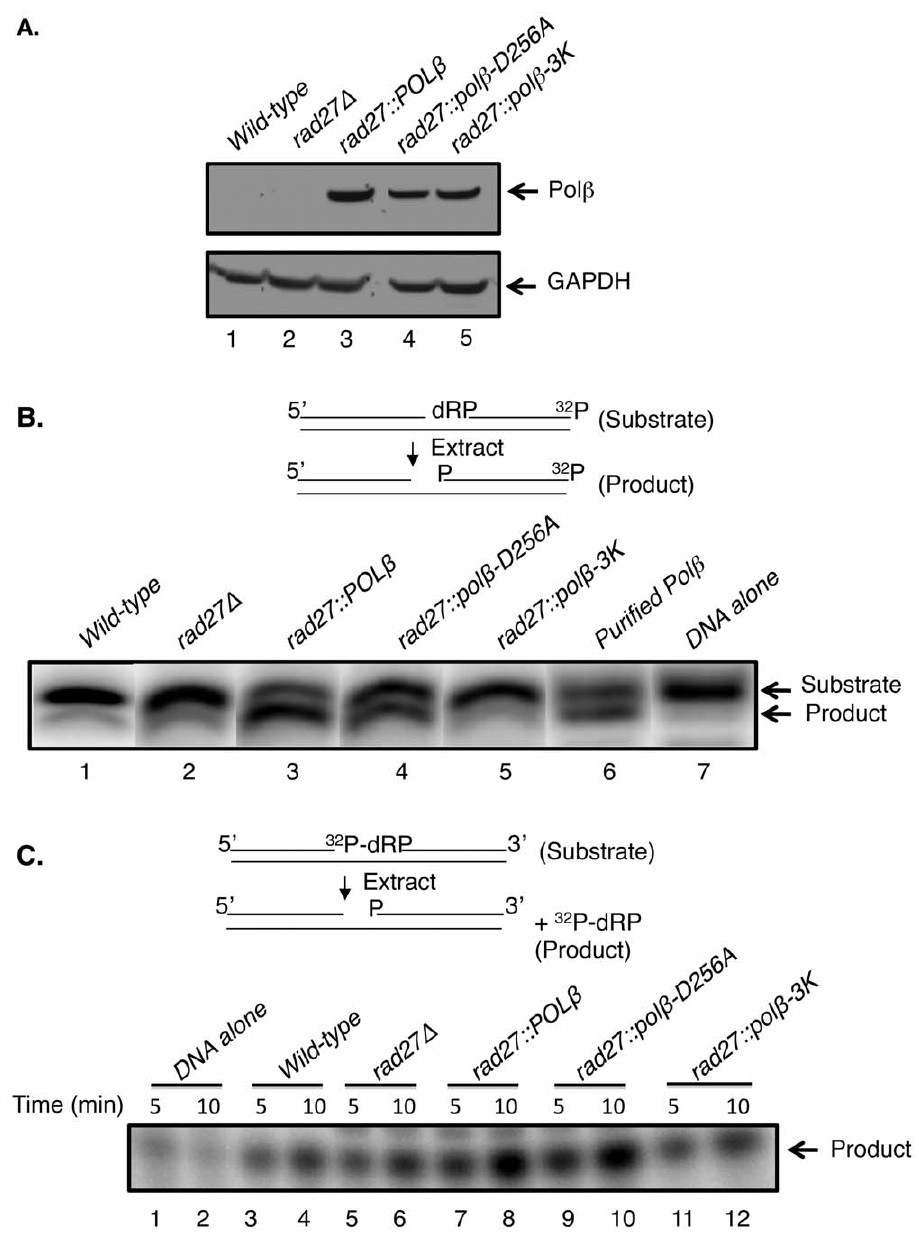
Figure 2. Expression of human POL b into S.cerevisiaerad27 mutants. (A) Immunoblot illustrating human Pol b expression in S. cerevisiae . Total extract protein was isolated (see Materials and Methods) from the indicated five strains. The indicated extracts (50 m l each) from wild-type (lane 1), rad27 D (lane 2), rad27::POL b (lane 3), rad27::pol b -D256A (lane 4), or rad27::pol b -3K (lane 5), respectively, were separated by SDS-PAGE, transferred to a nitrocellulose membrane, and probed either with an antibody against pol b (upper panel) or with an antibody against GAPDH (bottom panel). Bands corresponding to Pol b (39 kDa) were observed. GAPDH was used as a loading control. (B and C) 5 9 -dRP lyase assays. Schematic representations of the dRP lyase substrates (3 9 - or 5 9 -end 32 P-labeled) and the expected 32 P-labeled products formed as a result of lyase activity of the extract are illustrated. (B) DNA substrate (100 nM) was incubated with extracts from wild-type (lane 1), rad27 D (lane 2), rad27::POL b (lane 3), rad27::pol b -D256A (lane 4), and rad27::pol b -3K (lane 5), with purified Pol b (lane 6), or with DNA alone (lane 7). After a 15-min incubation at 35 u C, the DNA products were stabilized by NaBH 4 and analyzed as described under Material and Methods. The positions of the substrate and product are indicated. (C) 5 9 -end 32 P- labeled DNA substrate (100 nM) was incubated either with DNA alone (lanes 1–2) or with extracts from wild-type (lanes 3–4), rad27 D (lanes 5–6), rad27::POL b (lanes 7–8), rad27::pol b -D256A (lanes 9–10), and rad27::pol b -3K (lane11–12), respectively. After 5 and 10 min incubations at 35 u C, the DNA products were stabilized and processed as in (B). The position of the product is indicated. oligodeoxyribonucleotide (5 9 -UGTACGGATCCCCGGGTAC- respectively. A 34-mer (5 9 -GTACCCGGGGATCCG- 3 9 ) containing a uracil residue at the 5 9 -end or 3 9 -end was TACGGCGCATCAGCTGCAG-3 9 ) template was then annealed phosphorylated with Optikinase and [ c - 32 P]ATP or 3 9 -end with with 15-mer (5 9 -CTGCAGCTGATGCGC-3 9 ) and 19-mer 32 P- terminal deoxynucleotidyl transferase and [ a - 32 P] Cordycepin, labeled oligonucleotides by heating the solution at 90 u C for 3 min